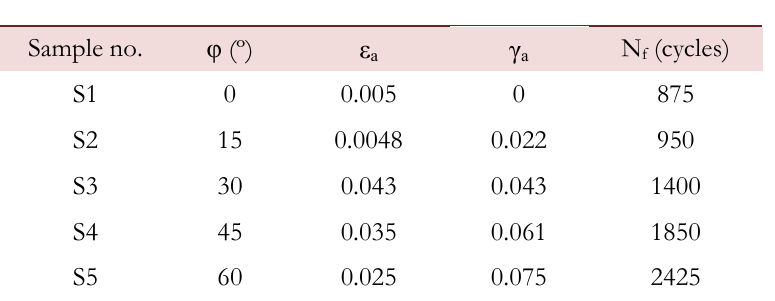
Table 2: Summary of five samples employed in this work, showing the angle ( φ ) between axial strain amplitude ( ε a ) and shear strain amplitude ( γ a ), as well as the fatigue life (N f ) of each sample.